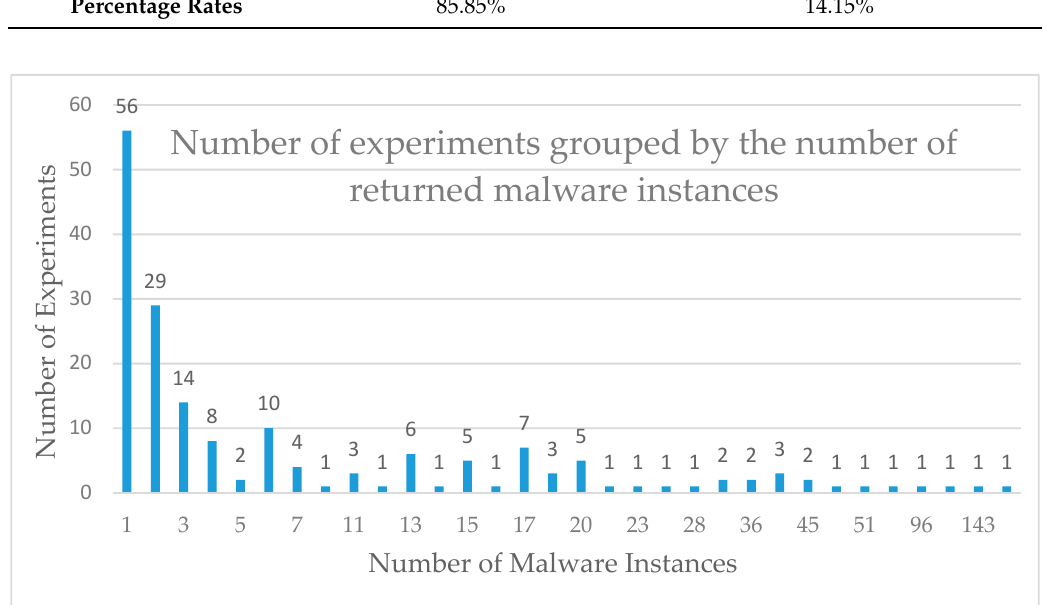
Figure 7. Distribution of the experiments in proportion to the malware instances each experiment returned.